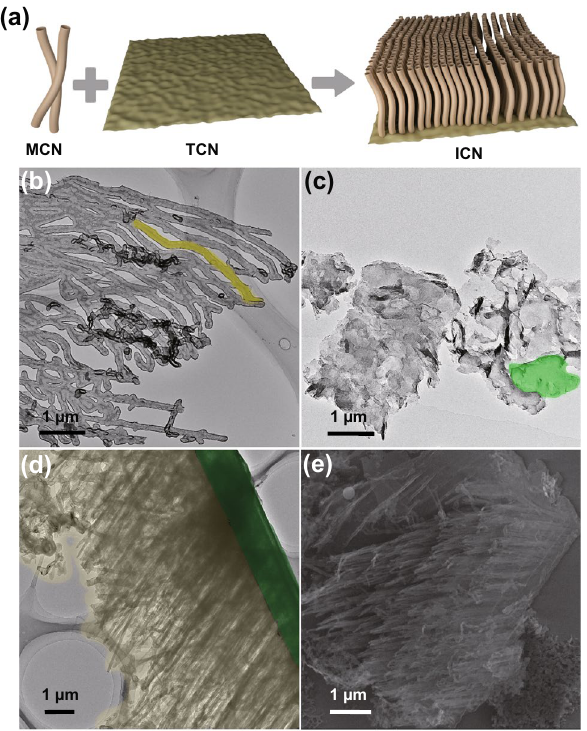
Fig. 2 a Schematic diagram of ICN. TEM images of b MCN, c TCN and d ICN-3. e SEM images of